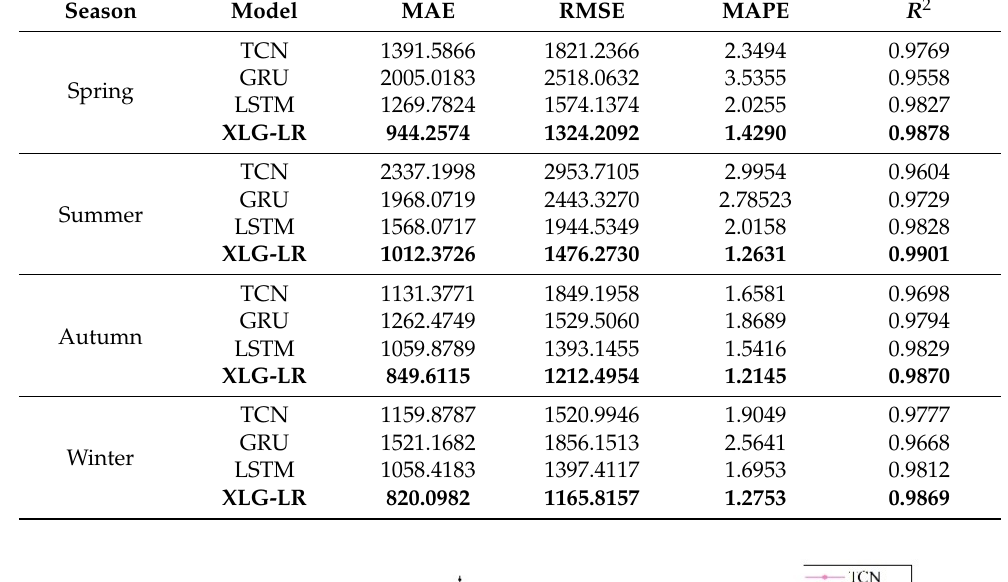
Table 7. Four-season Power Demand Forecasting of Different Models.